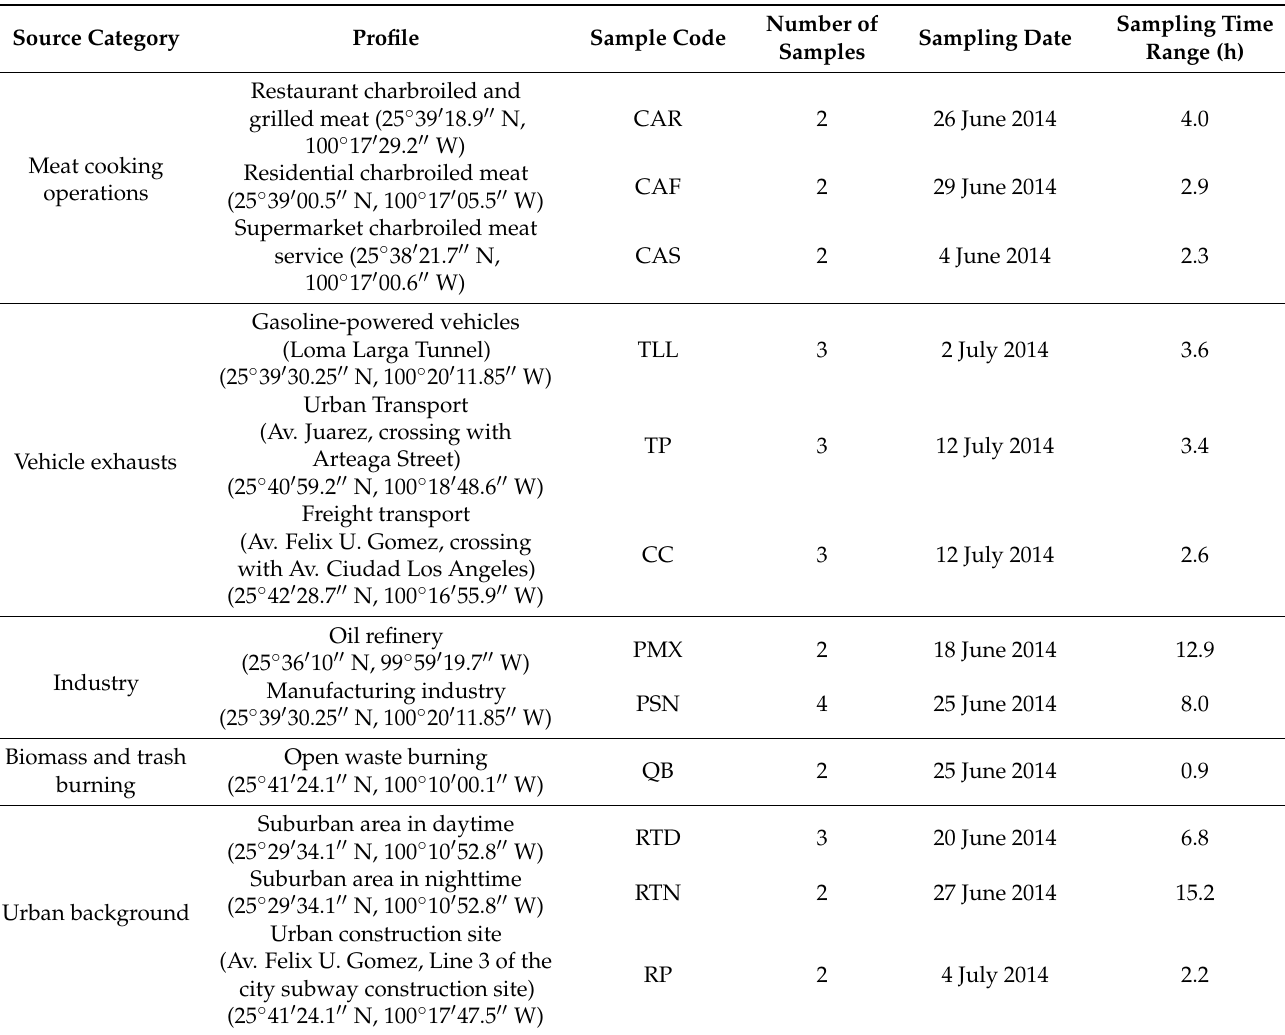
Figure 2. Methodology for the development of organic source profiles. Table 1. Summary of sampling schemes for the different emission